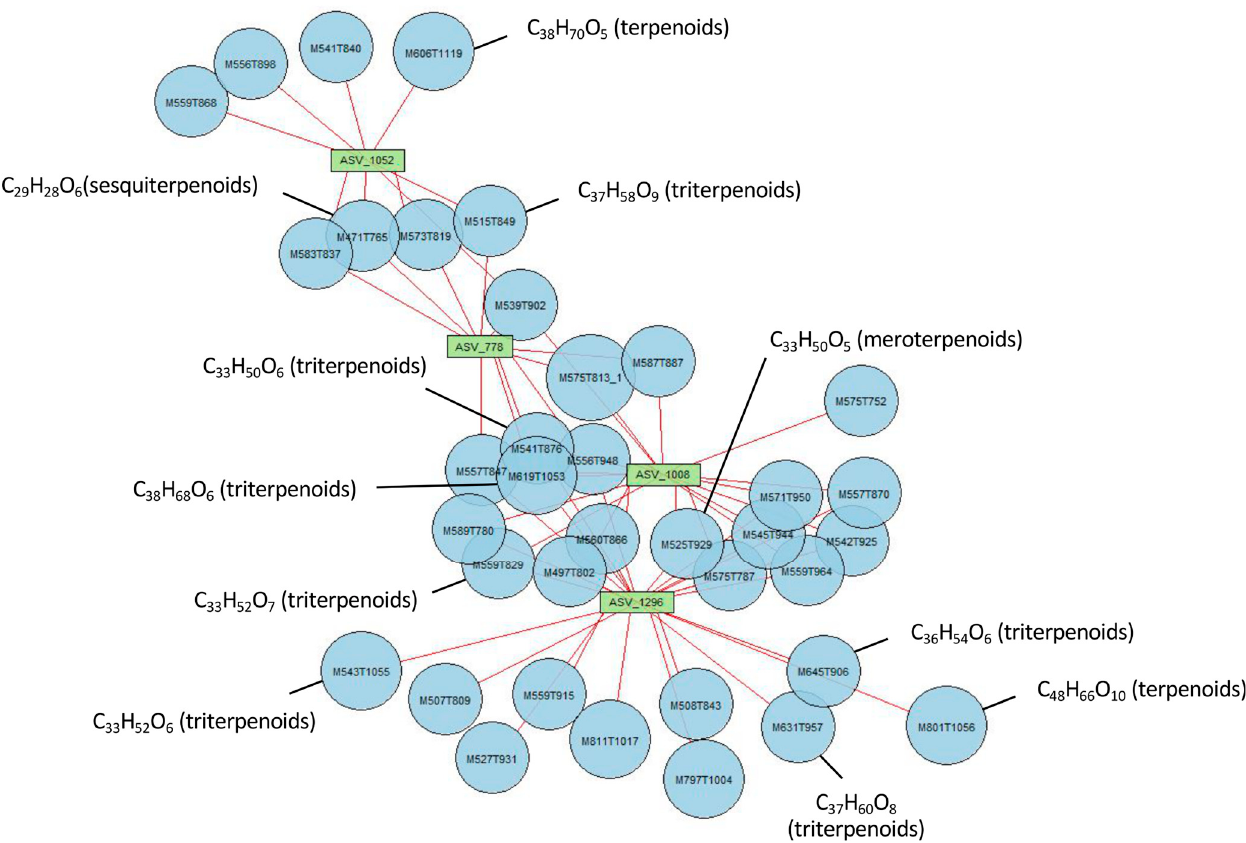
Figure 9. Correlation analyses between exometabolites and microeukaryotes. Only correlations above 98% were used to compute the network. Red lines between nodes indicate positive correlations.